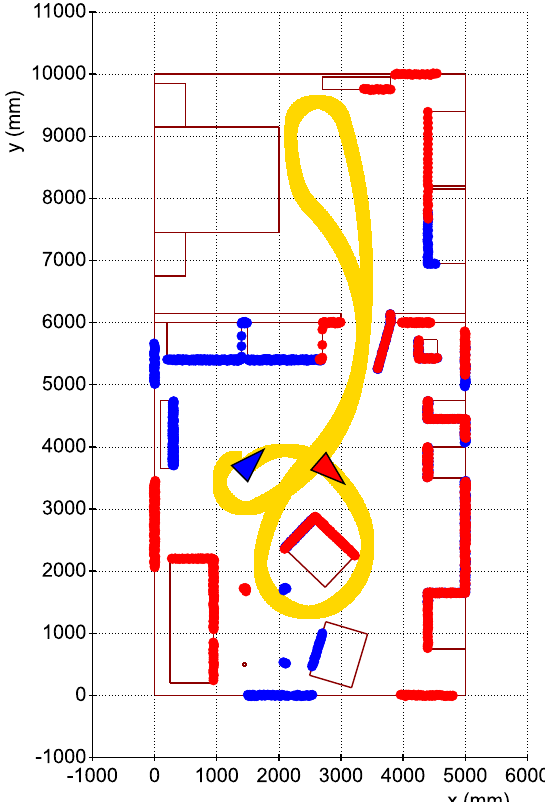
Figure 5. Simulation framework: an example of a map, robot trajectory ( yellow ) and two simulated laser scans ( red , blue